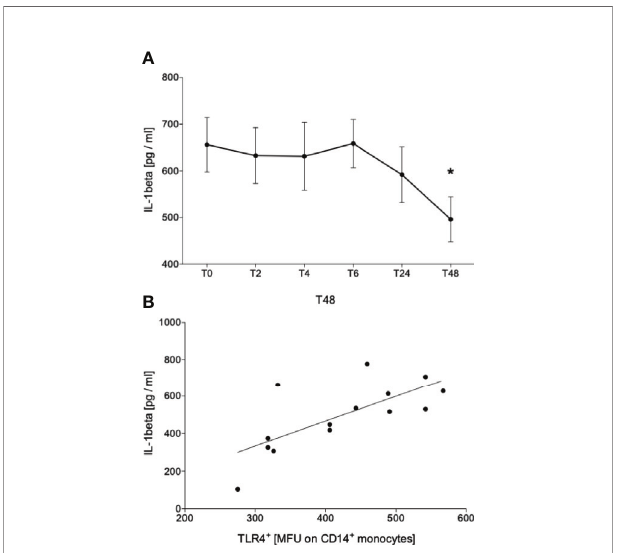
FIGURE 5 | Impact of acute alcohol intoxication on IL-1 b release after stimulation with lipopolysaccharide (LPS). IL-1 b was determined in blood of healthy volunteers (n=22) that was stimulated with LPS for 24 h before (T0) and 2 (T2), 4 (T4), 6 (T6), 24 (T24) and 48 (T48) hours after starting the alcohol consumption (A) . Spearman analysis of correlation between IL-1 b and TLR4 at T48 is shown (B) . Data are presented as mean ± standard error of the mean. *p < 0.05 vs .